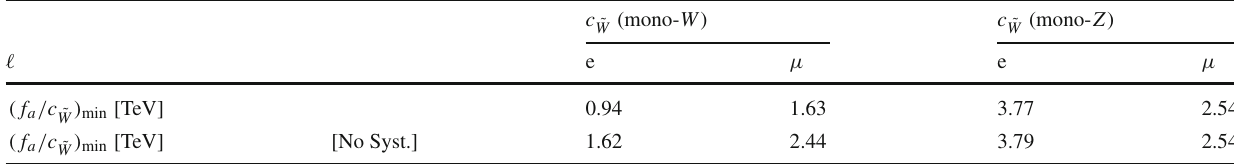
Table3 Present95% CL f a / c ˜ exclusionlimitsfortheeffectiveoper- W ator A ˜ from mono- W (left), inferred from the search presented in Ref, W [102] as detailed in Sect. 6.3.1 and mono- Z (right) inferred from the